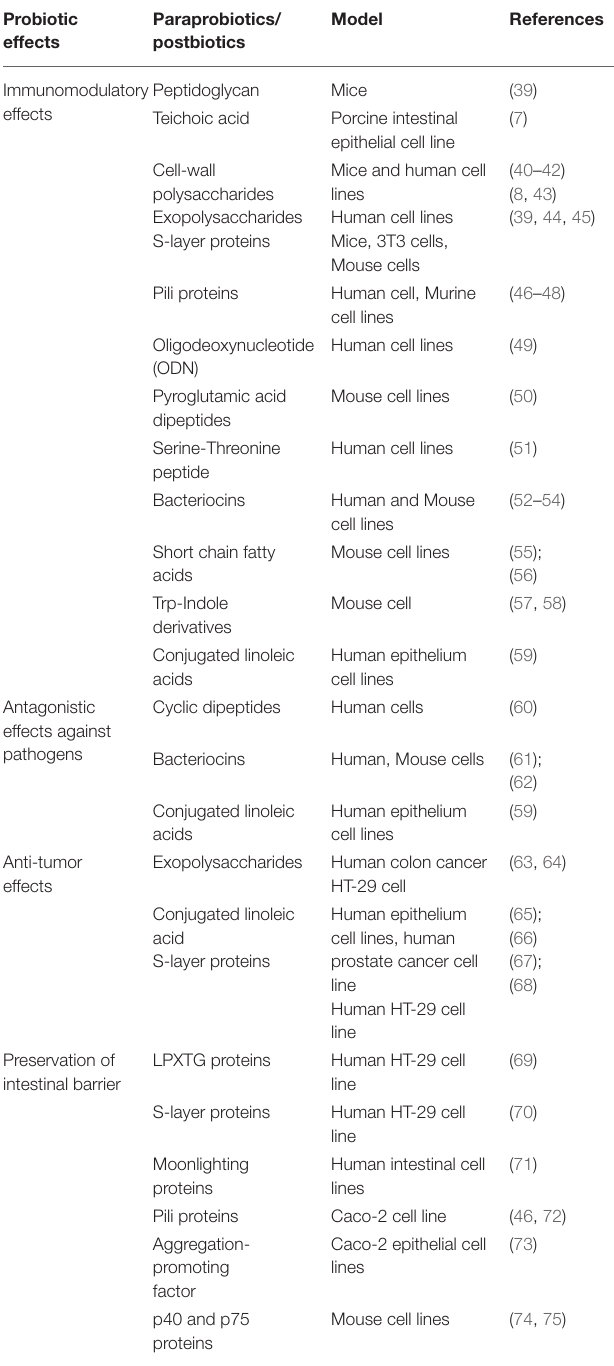
TABLE 1 | Probiotic effects of paraprobiotics and postbiotics in Lactobacilli